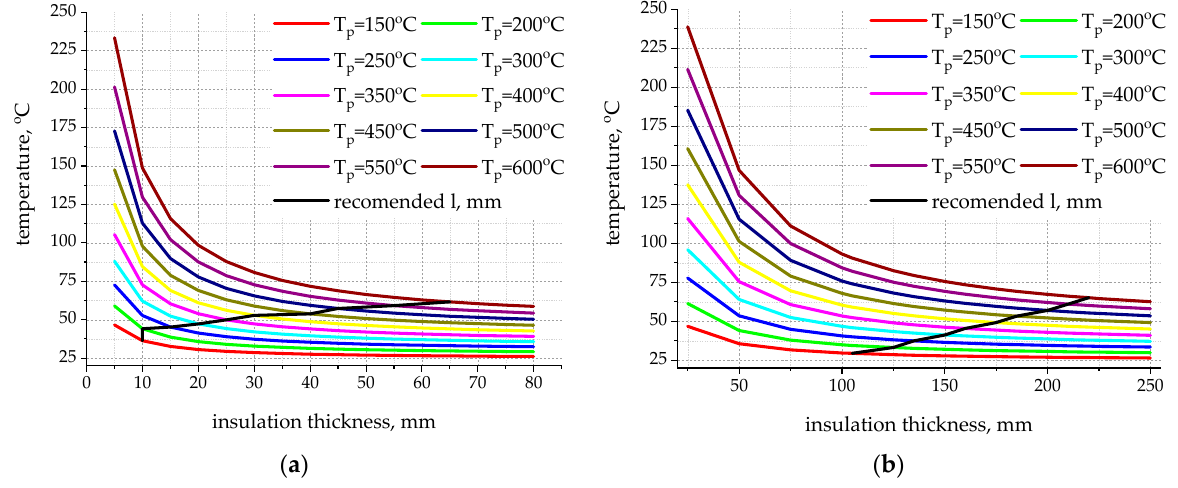
Figure 9. The temperature on the surface of the insulating material depending on the thickness of the insulation and the temperature of the heated pipe for the experimental conditions: ( a ) Aerogel; ( b ) Basalt fiber.